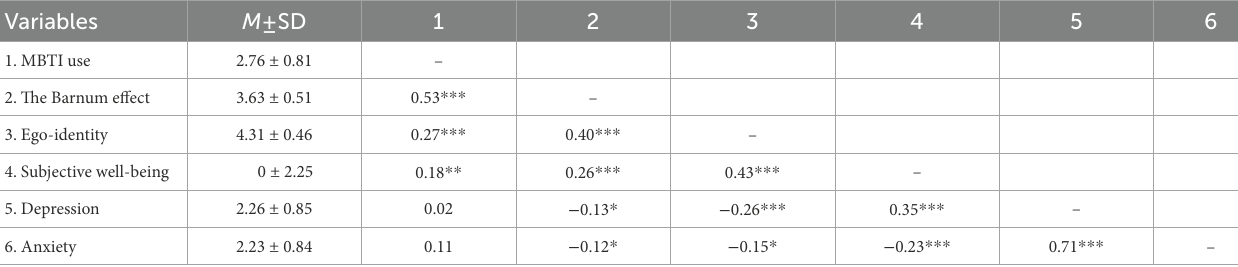
TABLE 2 Descriptive and bivariate correlations. Variables